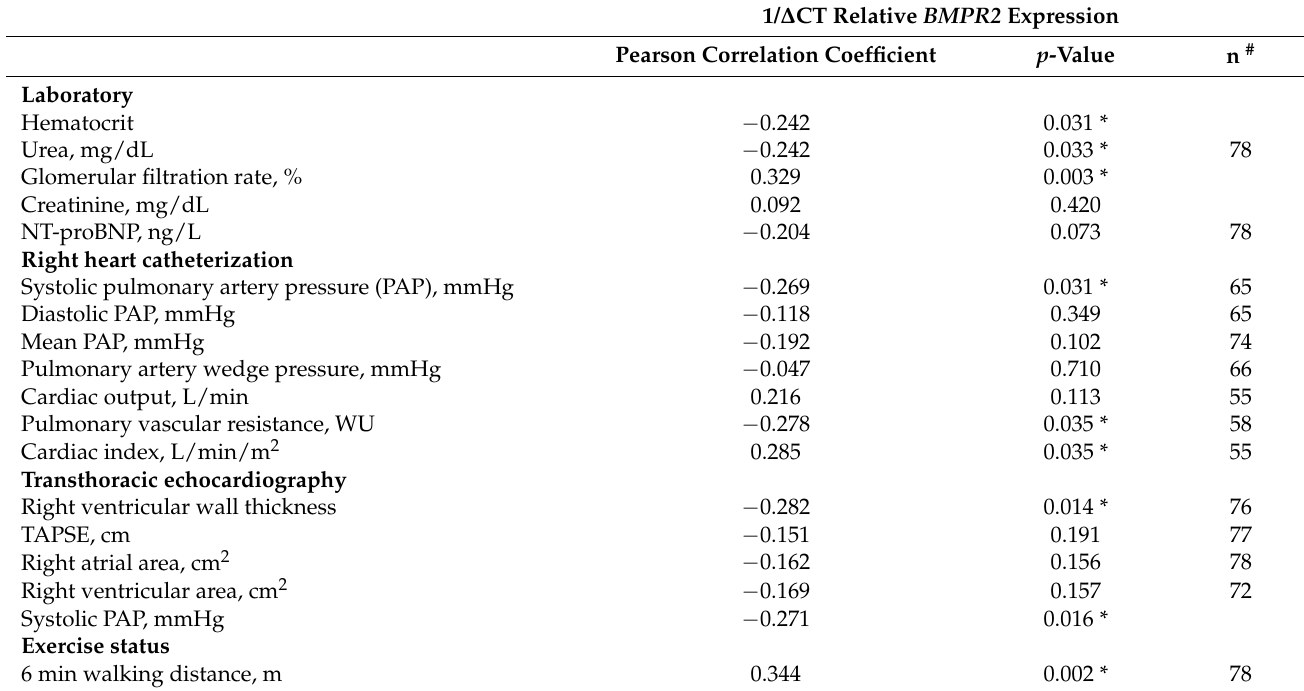
Table 2. Correlation of BMPR2 mRNA expression with laboratory and clinical